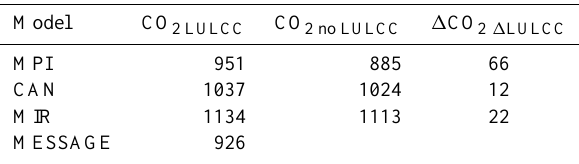
Table 3. Atmospheric CO 2 (ppm) concentrations in 2100. Table 4. 1T BGP and 1T BGC (K), averaged over the period 2071–